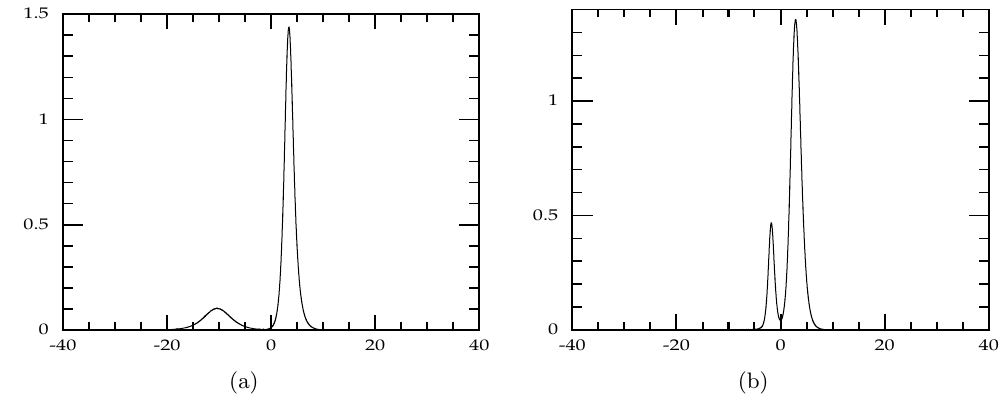
Figure 12 . Energy densities (and topological charge densities) of the SU(3) (cid:12)eld con(cid:12)gurations seen in cases I (a) and IV